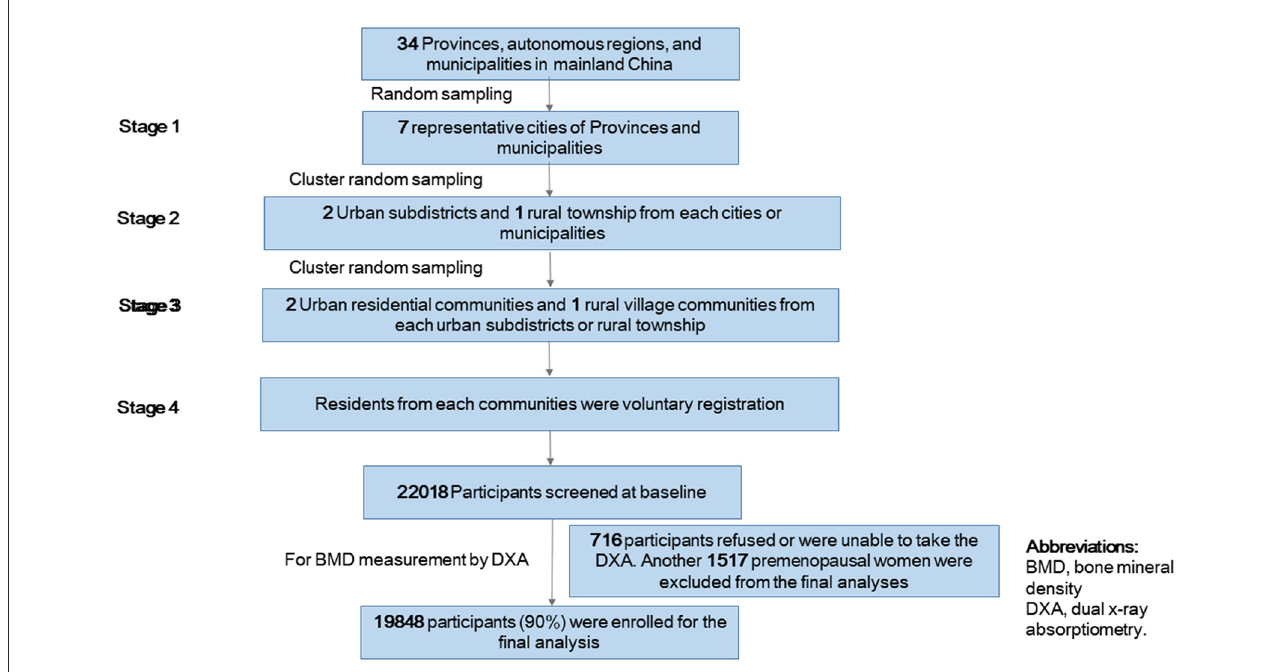
FIGURE1 Flowchart of participant